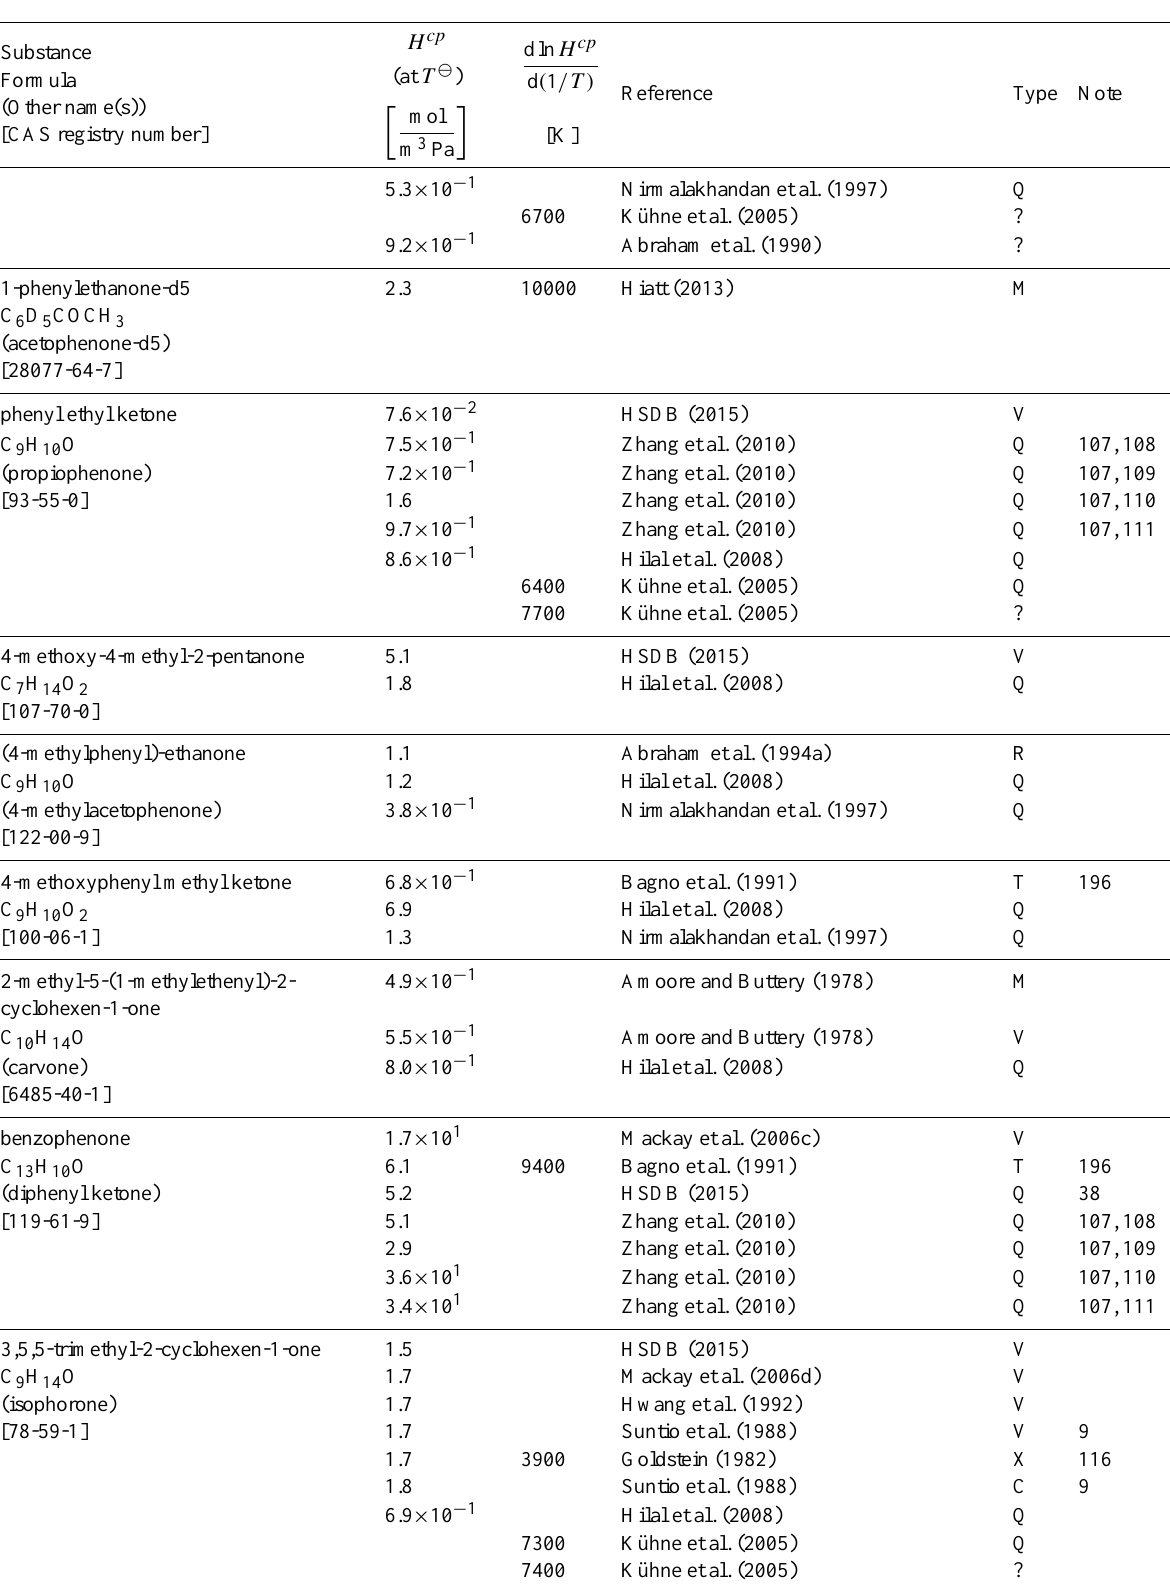
Table 6: Henry’s law constants for water as solvent